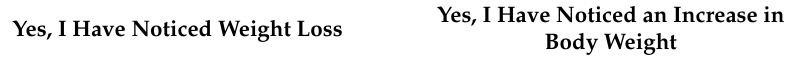
Table 3. Multivariate linear regression analysis of the association between age, gender, education level, living place and the effect of pandemic COVID-19 on body weight change.